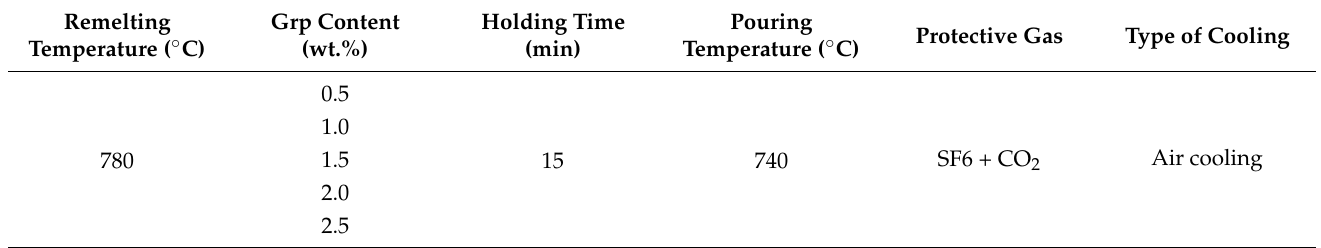
Figure 1. Schematic of experimental procedures. Table 1. The experiment parameters of the effect of Grp content on Graphite/AZ91D comosites. Remelting Grp Temperature ( ◦ C)